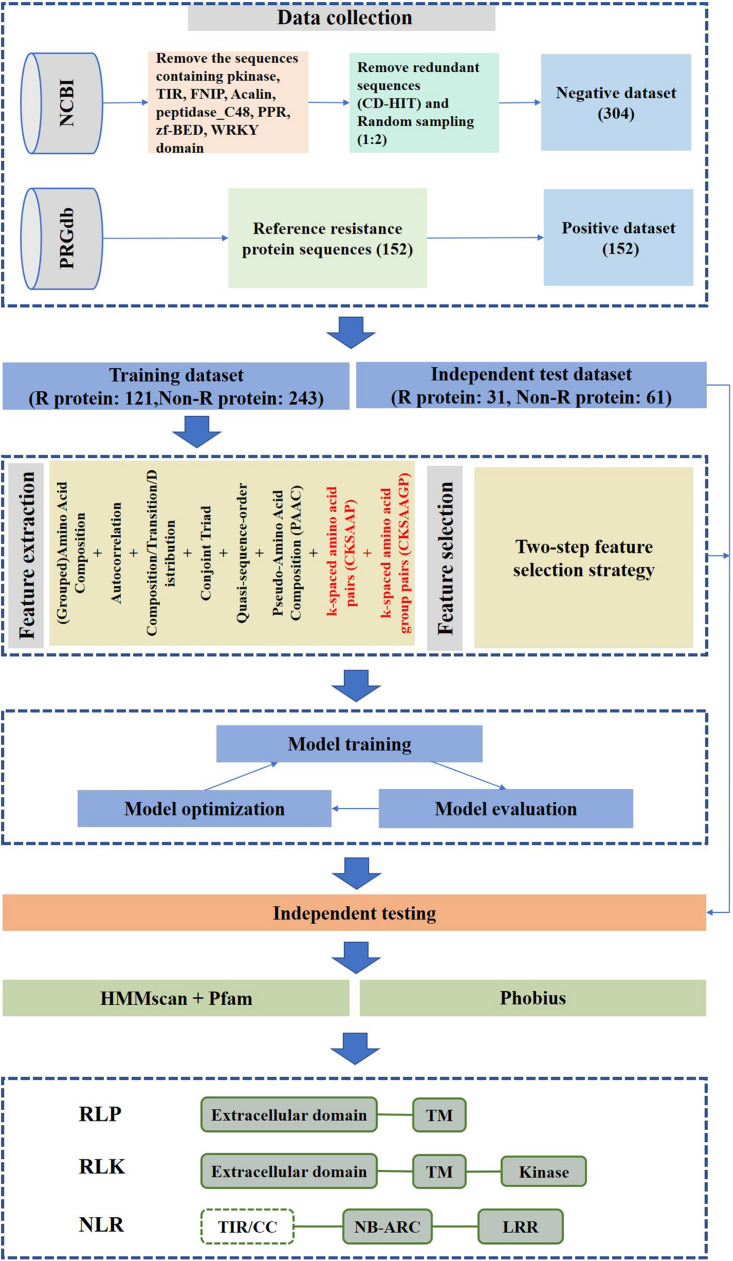
prPred workflow.